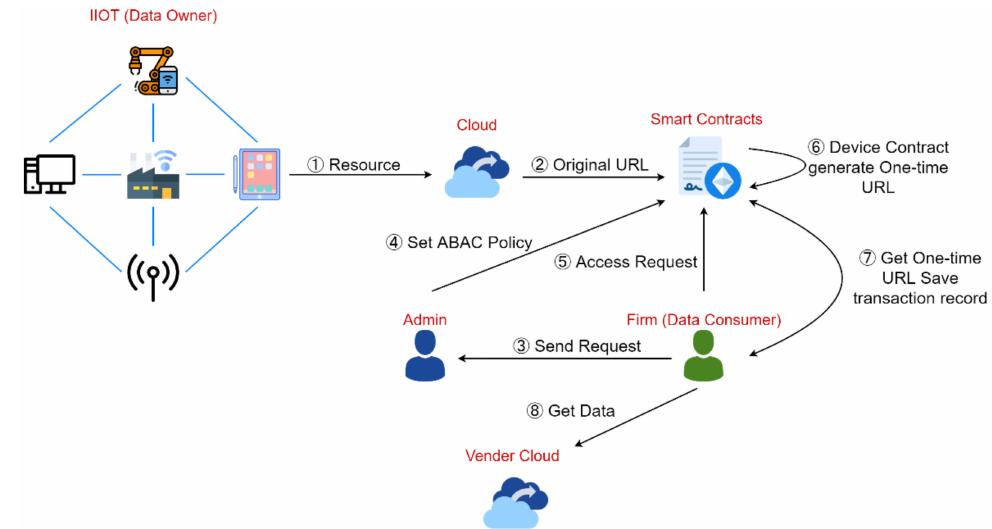
Figure 5. IIoT (Industrial Internet of Things) Operational Scenario.